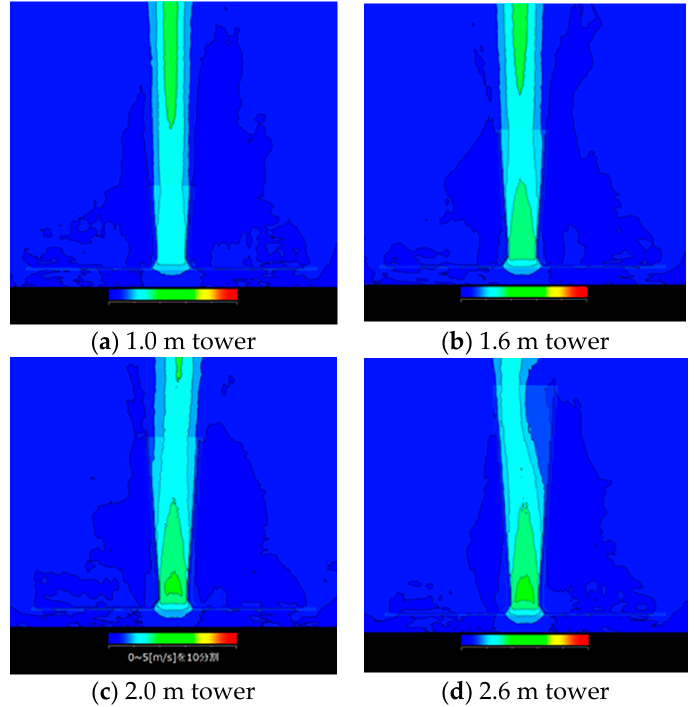
Figure 15. Time-mean updraft speed w vs. tower height h for diffuser models with a semi-open angle 4° and temperature difference ∆ Θ = 20 K. The w field is expressed by 10 intervals between 0 (blue) and 5 m/s (red). ( a ) 1.0 m; ( b ) 1.6 m; ( c ) 2.0 m; ( d ) 2.6 m tower height. Energies 2016 , 9 , 1077